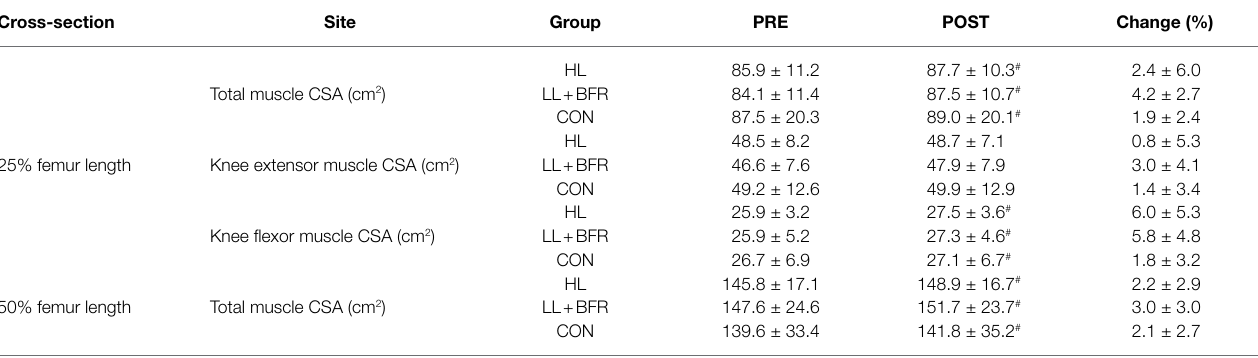
TABLE 2 | Muscle cross-sectional area (CSA) in heavy-load resistance training (HL), blood flow restriction training (LL + BFR), and non-training control (CON) groups.